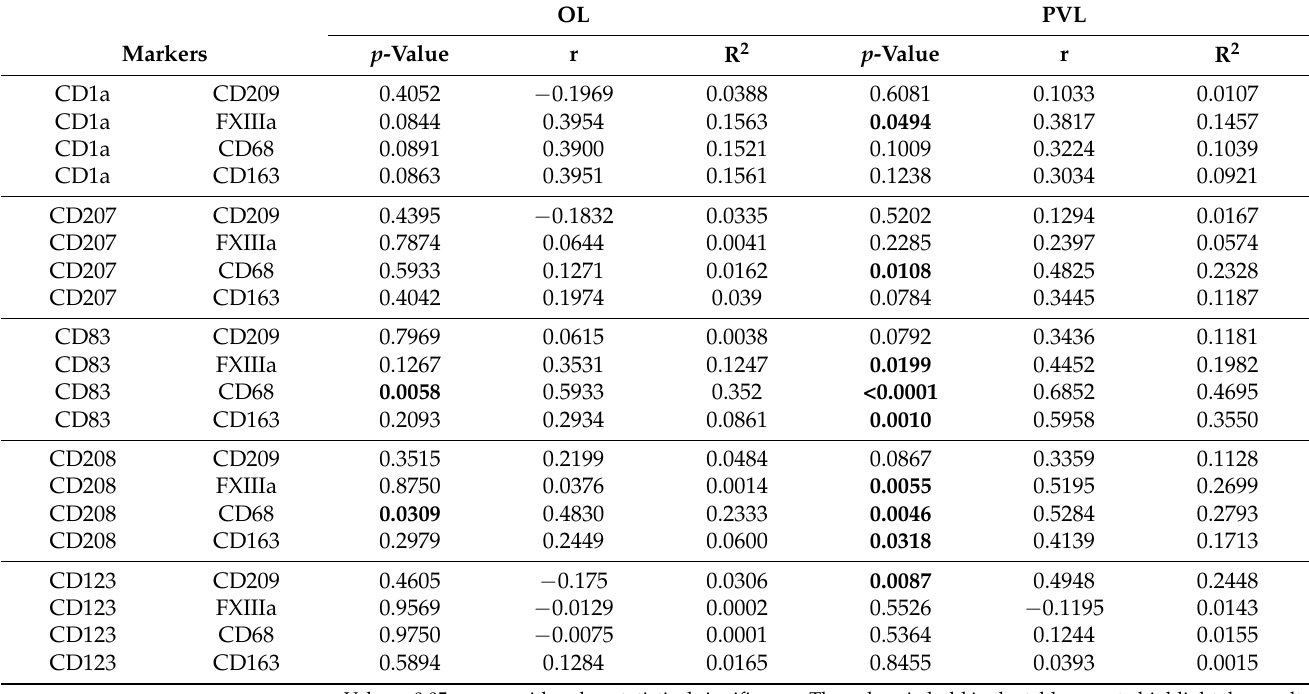
Table 2. Results of Pearson’s correlation between DCs and macrophages to different study groups. OL